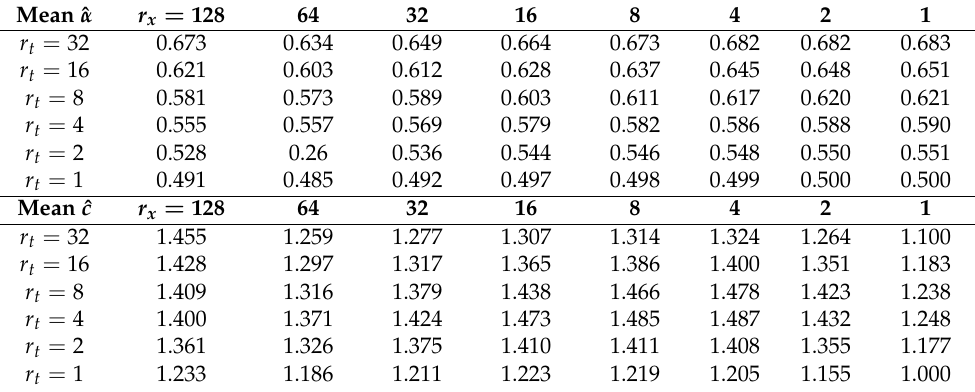
Table 1. Two-parameter estimation: Mean of the estimated ( α , c ) from 20 different full observations. The effect of sparsity of observation (i.e., sampling rations r x and r t ) on the mean of the estimated parameters is demonstrated. The true parameters are α ∗ = 0.5 and c ∗ = 1. The noise magnitude is fixed to (cid:101) ∗ = 0.1. A quasi-Newton optimization algorithm, L-BFGS-B algorithm, is employed to minimize the negative log-likelihood.